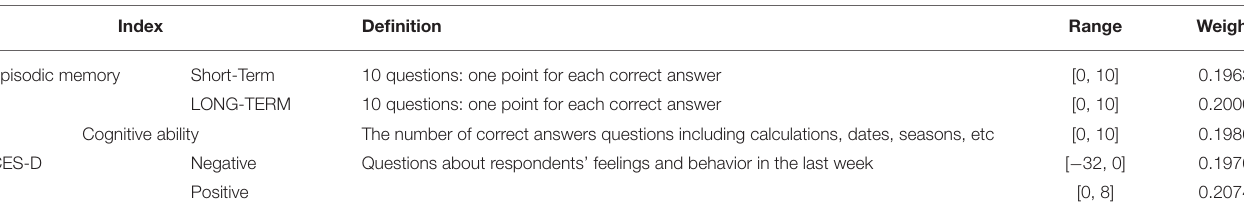
TABLE 1 | Construction of mental health index.